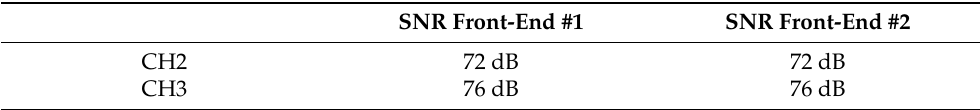
Table 5. Signal-to-noise ratio in decibels of the module for the selection of CH2 and